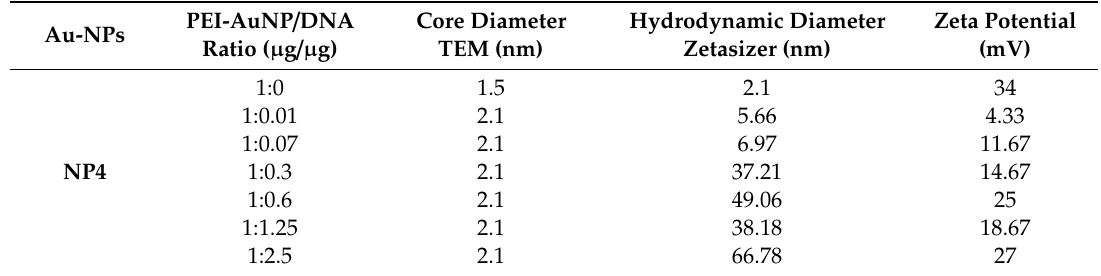
Table 2. Summary characterization of NP4 / DNA complexes with di ff erent amounts of DNA. PEI-AuNP / DNA Au-NPs Ratio ( µ g / µ